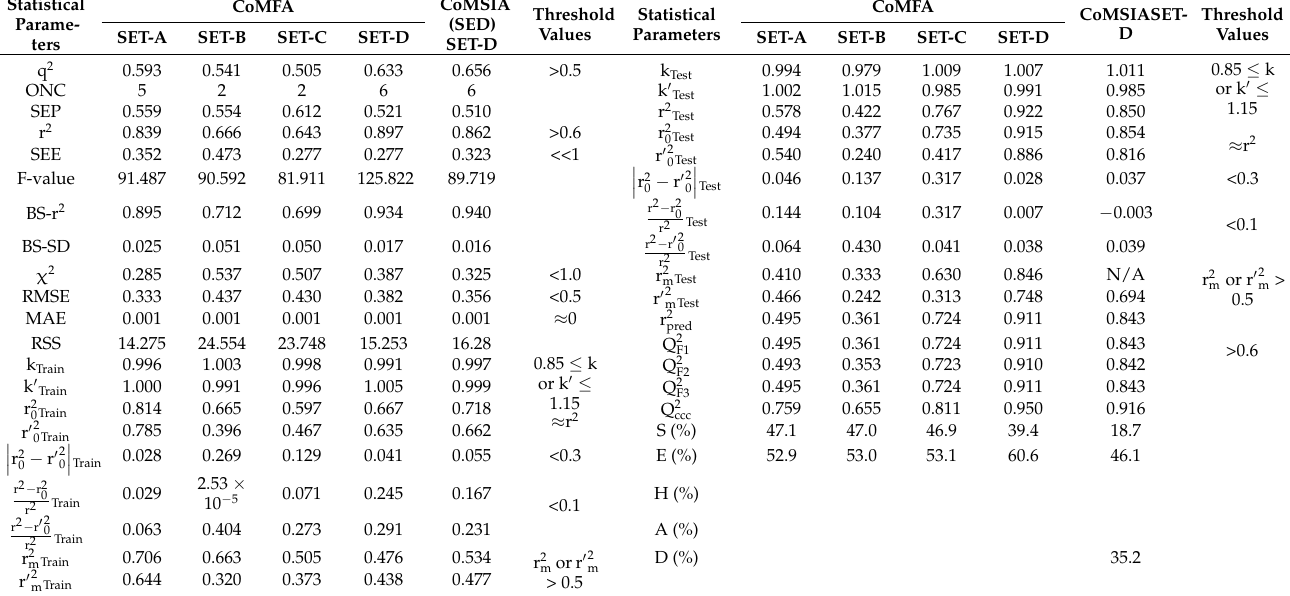
Table 1. Statistics of the CoMFA and CoMSIA